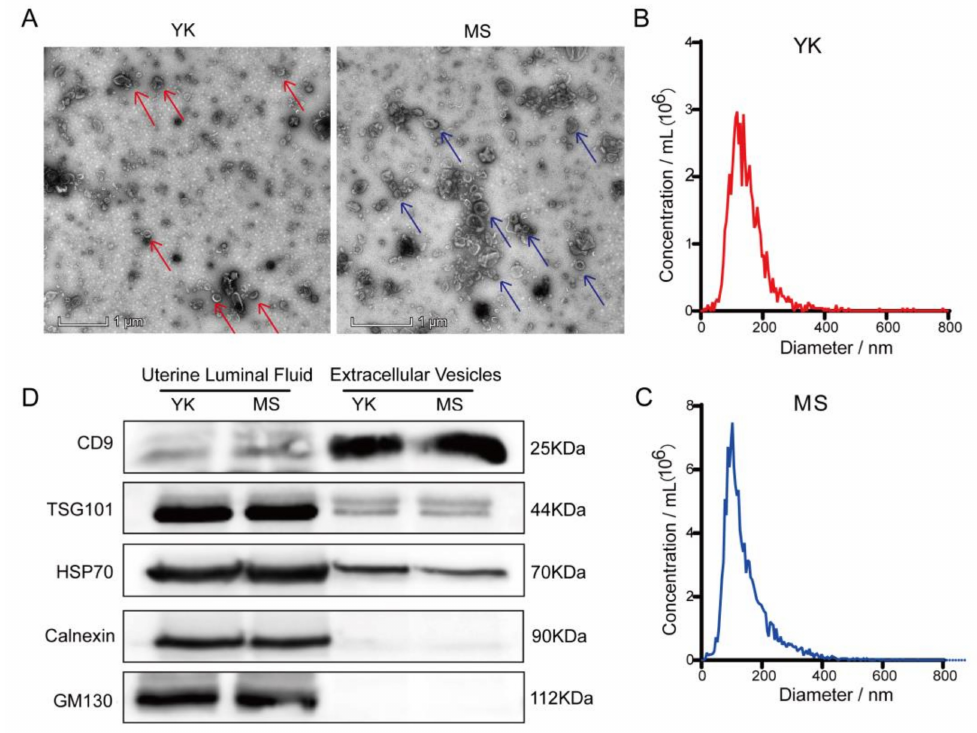
Figure 1. Characterization of extracellular vesicles (EVs) for identification. ( A ) Representative transmission electron microscope images are shown separately. The arrows point to extracellular vesicles. Scale bars = 1 µ m. ( B , C ) Nanoparticle tracking analysis (NTA) detects the size of EVs, which are mainly distributed at 100 nm. ( D ) Western Blot detected marker proteins CD9, TSG101 and HSP70 in EVs; Calnexin and GM130 were used as negative controls. YK: Yorkshire pigs, MS: Meishan pigs.